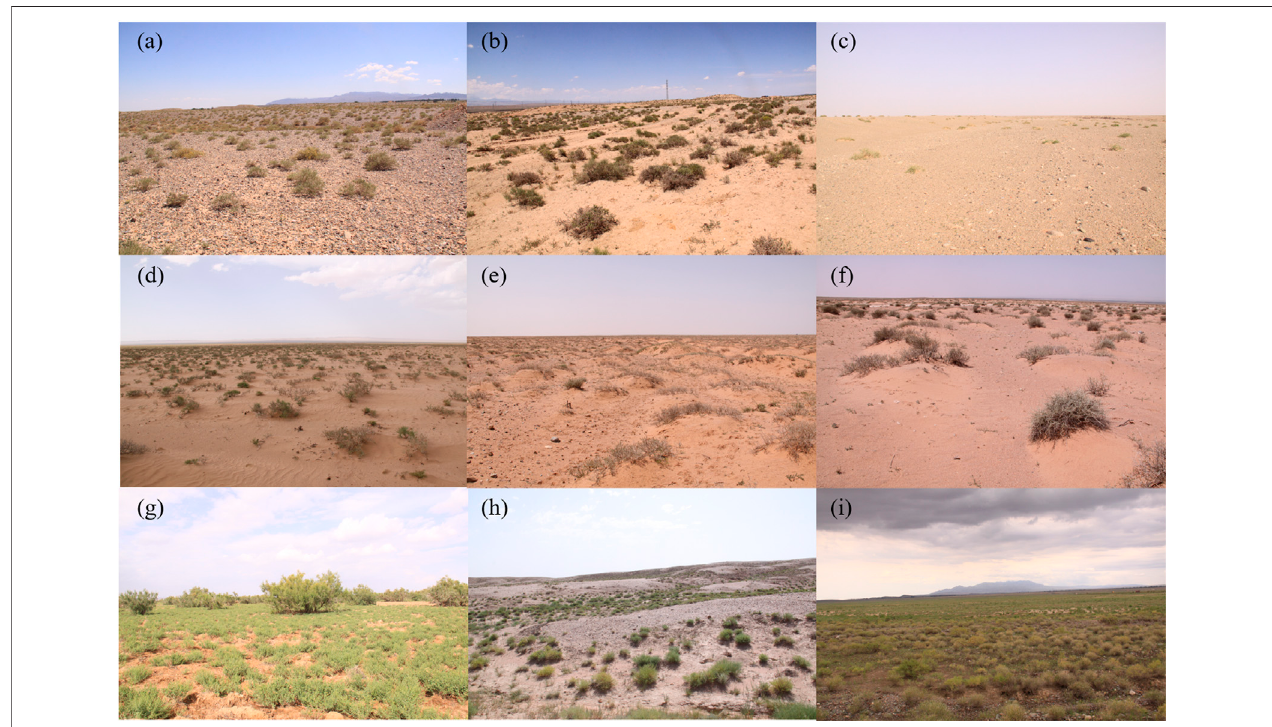
FIGURE 1 | Typical landscapes of the desert steppe in the Hexi Corridor, northwest China. Photo source: The authors ’ personal photographs.